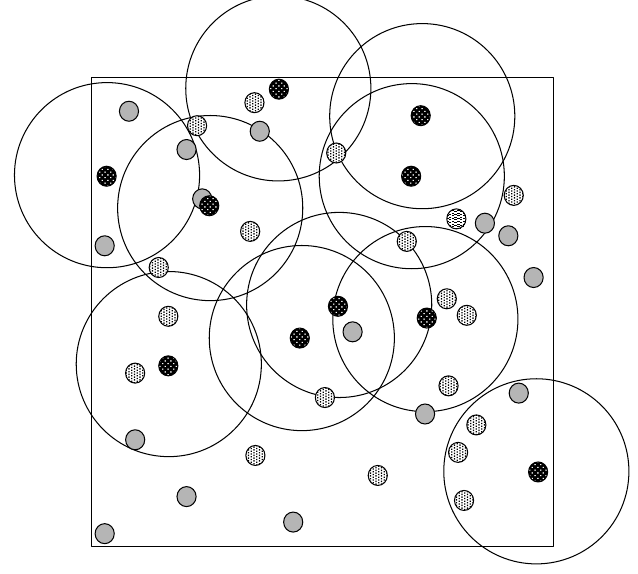
Figure 7. Random